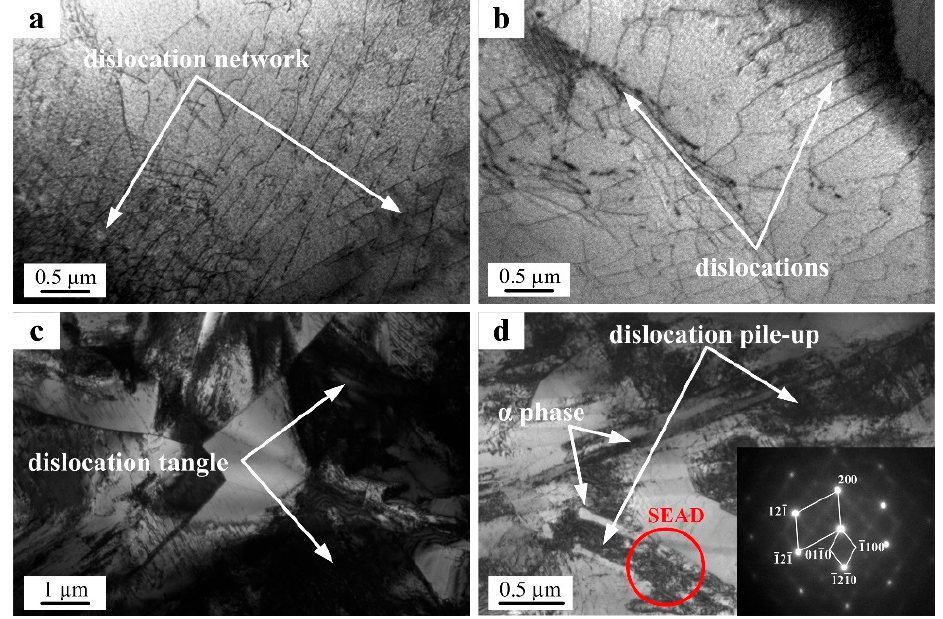
Figure 11. TEM images showing the dislocation configurations and microstructure of the PM and IM Ti-5553 alloys deformed at 700 °C/0.1 s − 1 : ( a , b ): PM alloy and ( c , d ): IM alloy. Ti-5553 alloys deformed at 700 ◦ C/0.1 s − 1 : ( a , b ) PM alloy and ( c , d ) IM